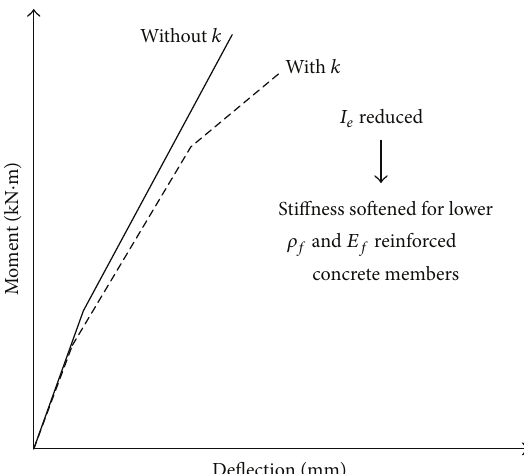
Figure 4: Basic concept of considering parameter 𝑘 .